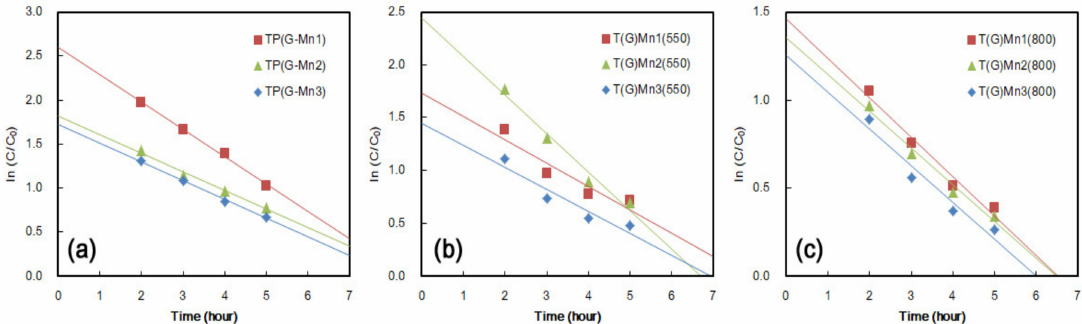
Figure 6. Kinetics of photocatalytic NOx degradation: ( a ) TP(G–Mn1), TP(G–Mn2) and TP(G–Mn3); ( b ) T(G–Mn2)(550) NW, T(G–Mn3)(550) NW, and T(G–Mn1)(550) NW; and ( c ) T(G–Mn1)(800) NW, T(G–Mn2)(800) NW and T(G–Mn1)(800)